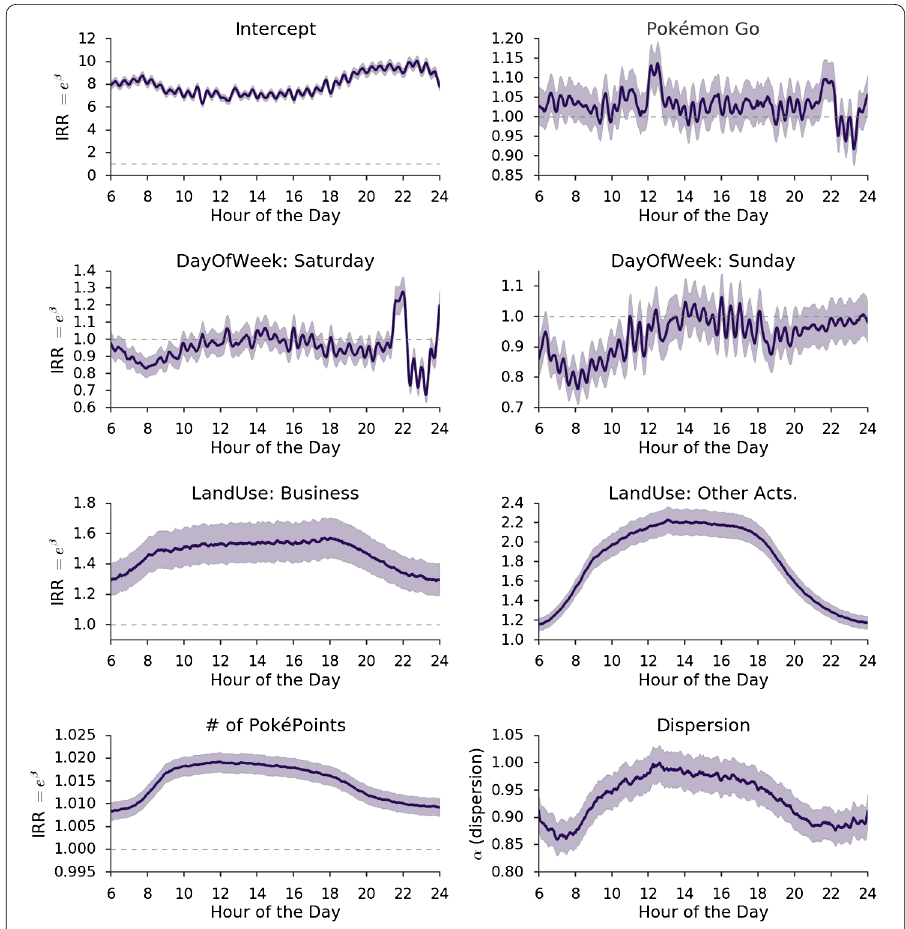
Figure 4 Covariates and dispersion ( α ) for each factor of the Negative Binomial regression applied to the 1-minute snapshots. The Intercept factor includes the base values of each factor: 0 for the Pokémon Go factor, business_day for DayOfWeek , residential_area for LandUse , and 0 for the number of PokéPoints